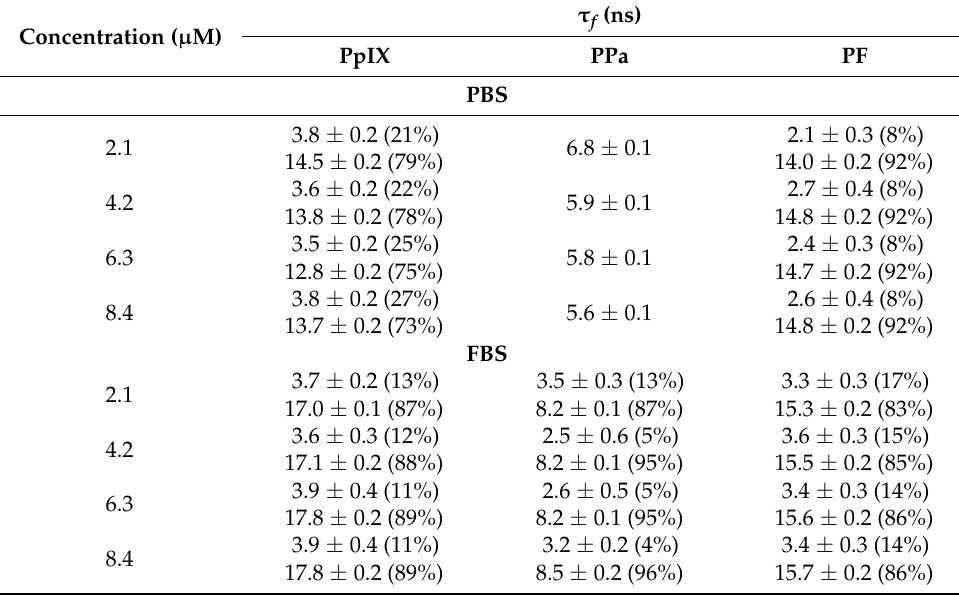
Table 8. Fluorescence lifetimes of PpIX, PPa, and PF in PBS and FBS ( λ exc = 408 nm) at room